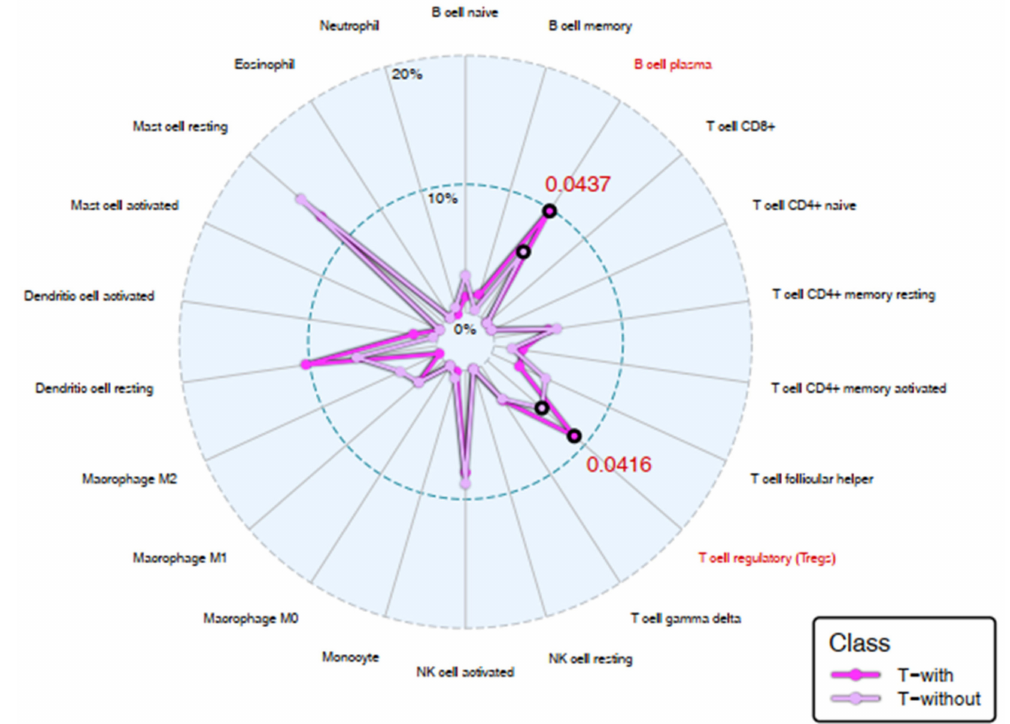
Figure 7. Immune landscape: CIBERSORT analysis. Radar plot showing results obtained after the CIBERSORT procedure. Each portion of the graph represents one of the 22 human cell phenotypes considered in the method, while dots display the mean proportion of each cell population in the T-with (magenta line) and T-without groups (pink line). B cell plasma and T cell regulatory (Tregs) populations (highlighted in red) showed a weak statistically significant di ff erence ( p -values in red) between the two groups, by performing a Wilcoxon rank sum test with a level of significance of α =